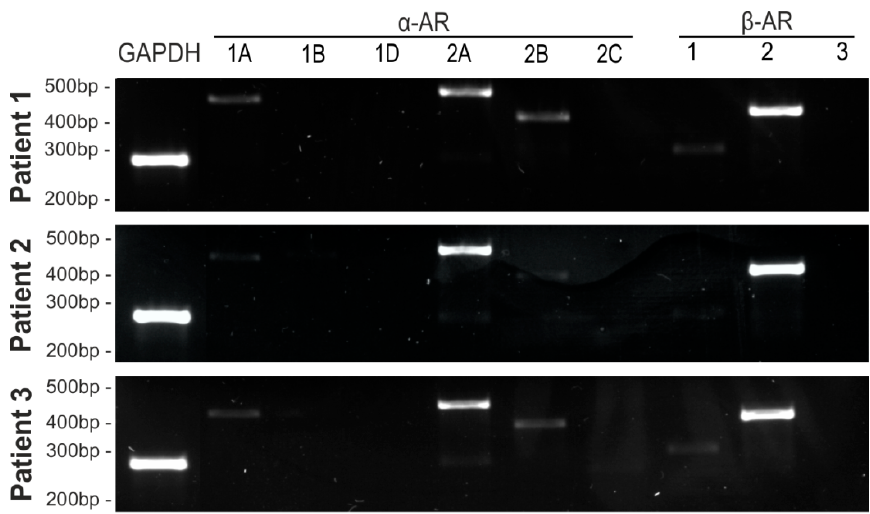
Figure 2. Adrenergic receptor profile of OA chondrocytes. Gene expression of different adrenoceptor subtypes in untreated primary chondrocytes isolated from three patients at day 0 (representative images of three OA donor cell isolations).